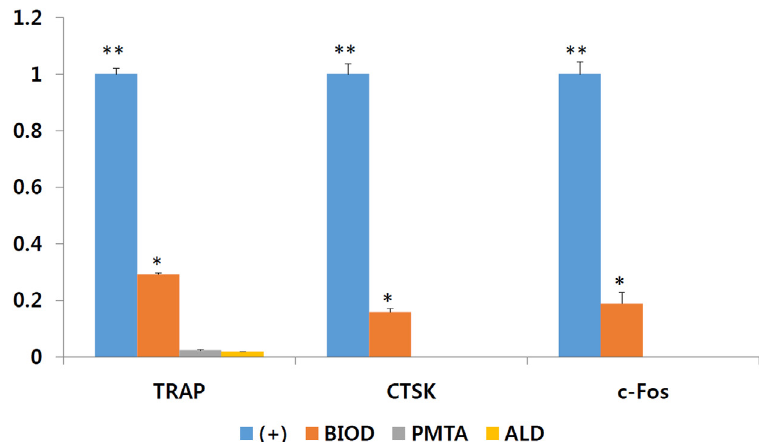
Figure 4- CSCs and ALD exhibited an inhibitory effect on osteoclast differentiation and function. (A) mRNA expression of osteoclastic markers TRAP, CTSK, and c-Fos were analyzed by qRT-PCR. mRNA expression of osteoclastic markers was decreased in BIOD, PMTA, and ALD compared with (+) CTL (P<0.05). Different asterisks (* and **) means that they showed significantly different each other. ALD=alendronate; BIOD=Biodentine; CSCs=calcium silicate-based cements; CTSK=cathepsin K; PMTA=ProRoot MTA; TRAP=tartrate-